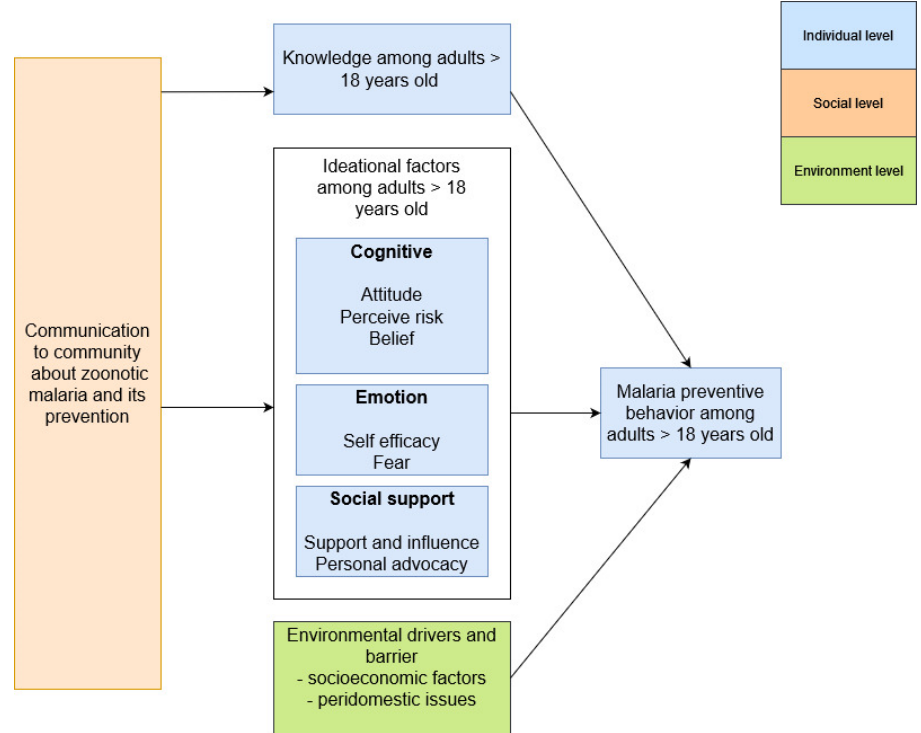
Figure 2. The proposed study